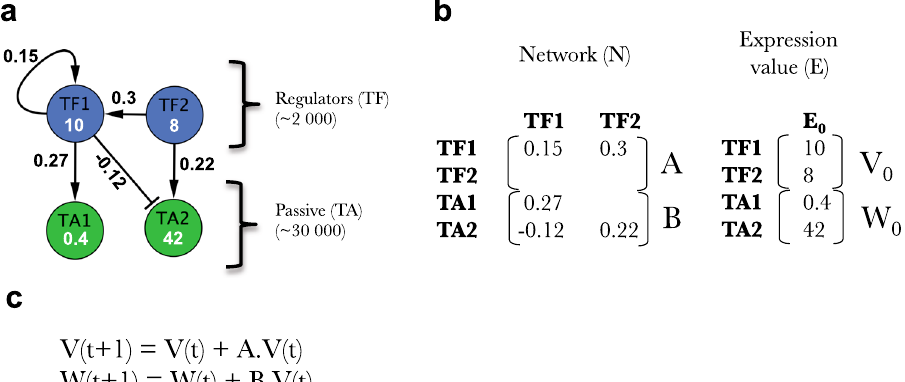
Fig. 1 Overall organization of the FRANK algorithm (Fast Randomizing Algorithm for Network Knowledge). a Network graph for four genes (two transcription factors [TF]) and two targets (TA). Because of its simple architecture FRANK is able to simulate very large networks (accepting several thousands of TF and TA) and associated gene expression. The model accepts positive, negative and auto-regulations of TFs. b The Network graph in panel A is formalized as a network matrix named N made of two sub-matrices: A (TF effect on each others) and B (TF effect on TA). Gene expression at step 0 is then randomized ( E 0 ) made of two sub-vectors: V 0 (being the expression values of TF) and W 0 (being the expression values of TA). c Formulas used to iteratively simulate gene expressions across iterative “ time points ” t . Gaussian